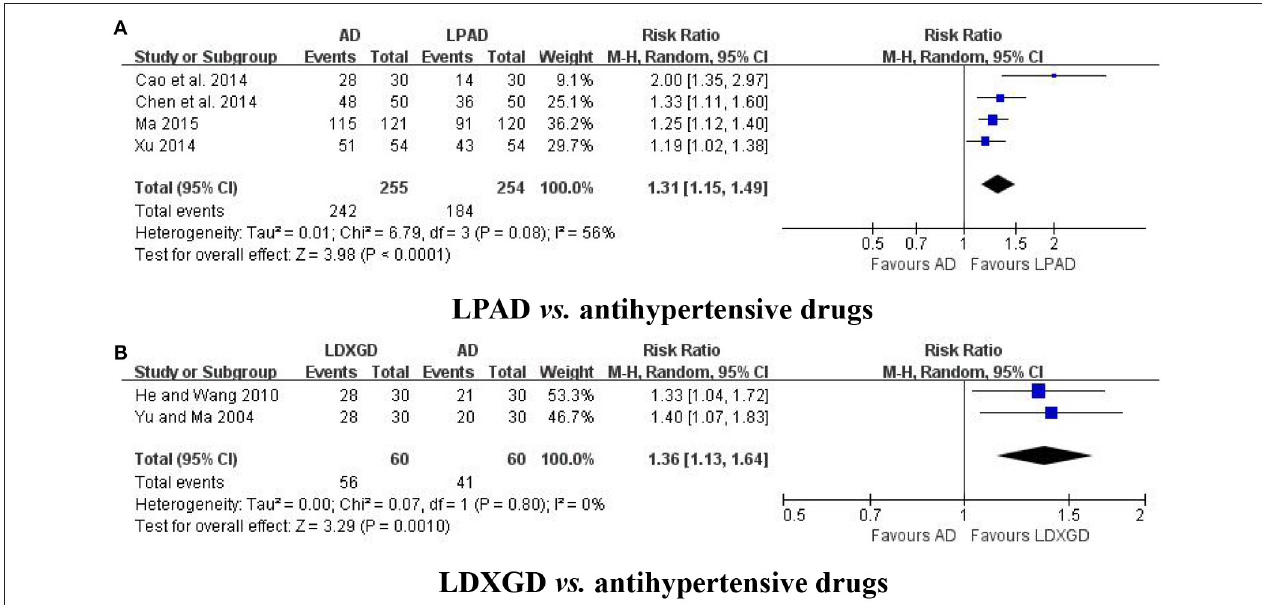
FIGURE 4 | Forest plots of the efficacy of LPAD for the outcome of symptoms. AD, antihypertensive drugs; LDXGD, longdanxiegan decoction; LPAD, longdanxiegan decoction plus antihypertensive drugs. (A) symptoms: LPAD vs. antihypertensive drugs. (B) symptoms: LDXGD vs. antihypertensive drugs.